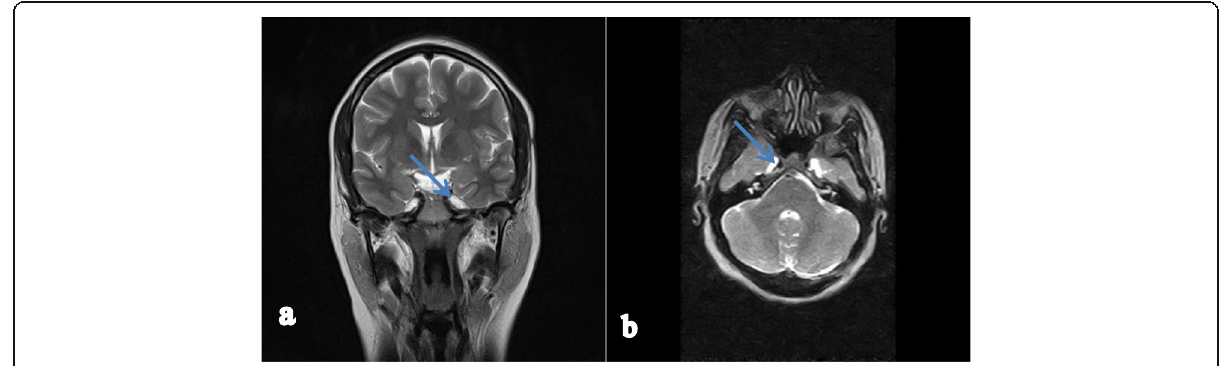
Fig. 6 MRI brain T2 sequence of a 31-year-old lady showing prominent Meckel caves in coronal ( a ) and axial ( b ) views